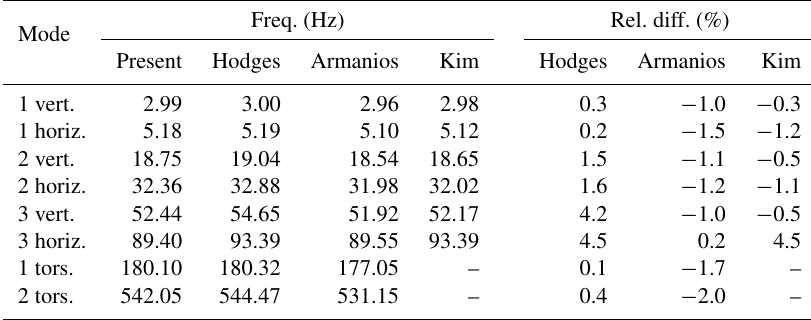
Table 1. Eigenfrequencies of a coupled cantilever obtained with the present model compared to results by Hodges et al. (1991), Armanios and Badir (1995) (both beam models), and Kim et al. (2013) (shell model).